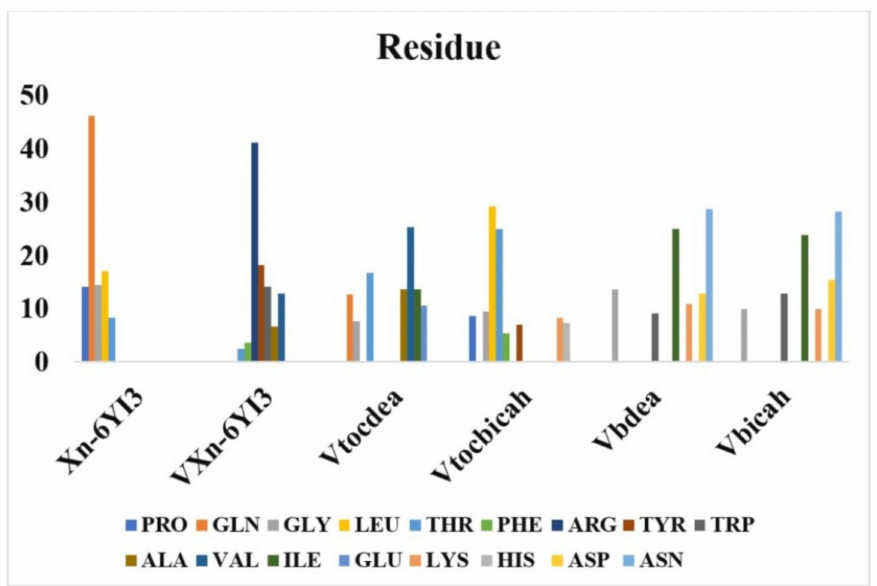
Figure 5. The % binding energies of 6YI3’s important amino acids on the various compounds inves- tigated inside the paper. Reprinted/adapted with permission from Ref.